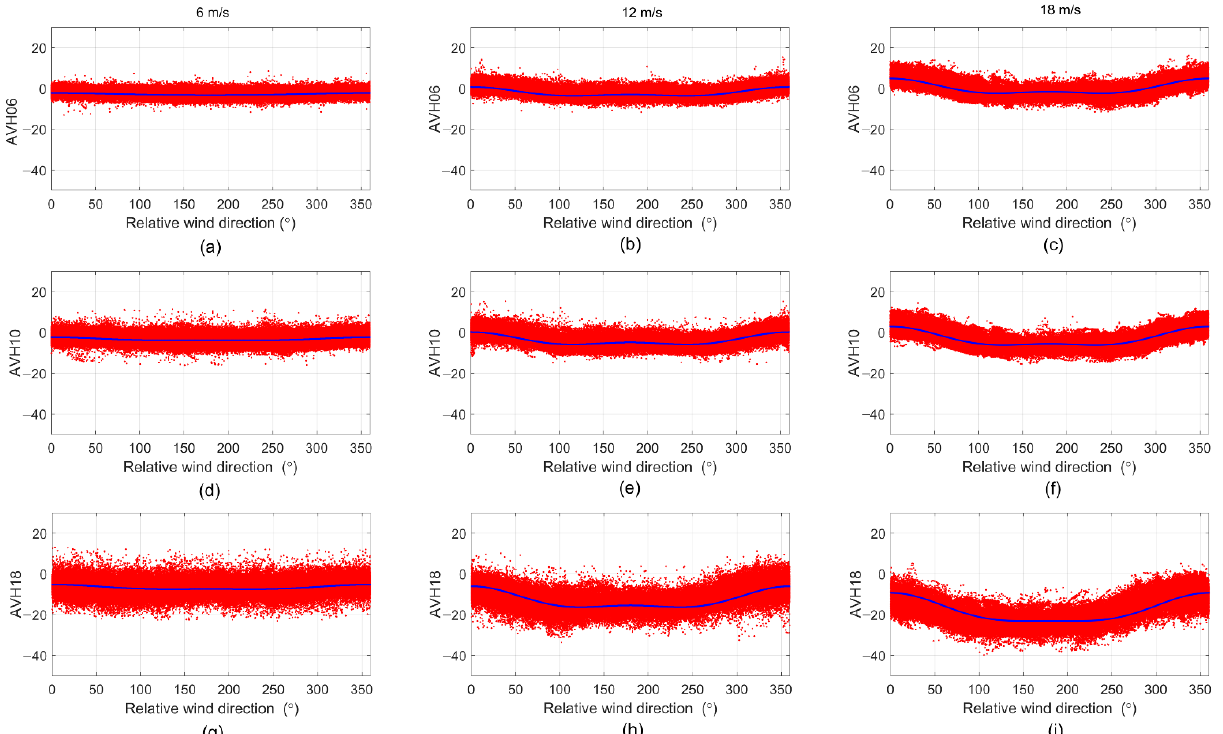
Figure 10. The directional dependence of AVH for three frequencies and three wind speeds: ( a ) AVH06 at 6 m/s; ( b ) AVH06 at 12 m/s; ( c ) AVH06 at 18 m/s; ( d ) AVH10 at 6 m/s; ( e ) AVH10 at 12 m/s; ( f ) AVH10 at 18 m/s; ( g ) AVH18 at 6 m/s; ( h ) AVH18 at 12 m/s; ( i ) AVH18 at 18 m/s.